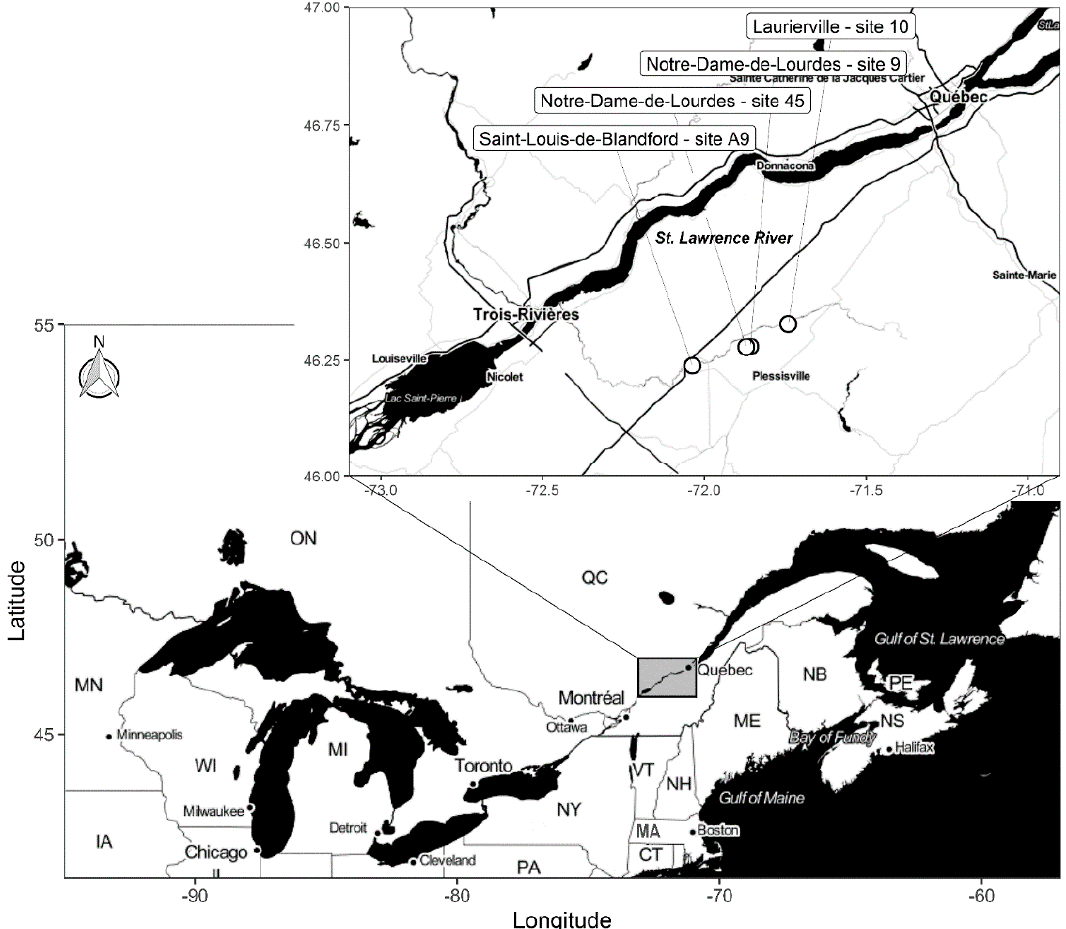
Figure 1. Map of the four study sites located on the south shore of the St. Lawrence River in Quebec, Canada. Table 1. Soil particle size distribution and mean and standard deviation (SD) of soil data at each experimental site across 144 plots in June